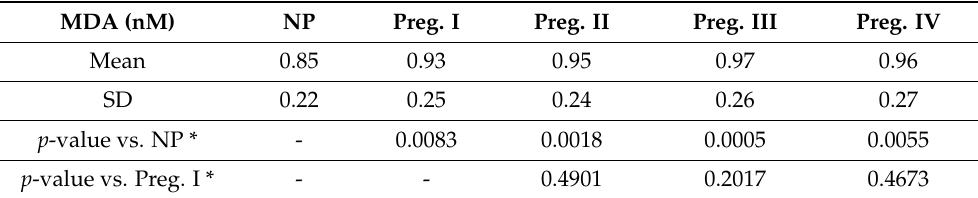
Table 3. Oxidative stress level measured as MDA level in the saliva of pregnant women at different gestational ages and non-pregnant